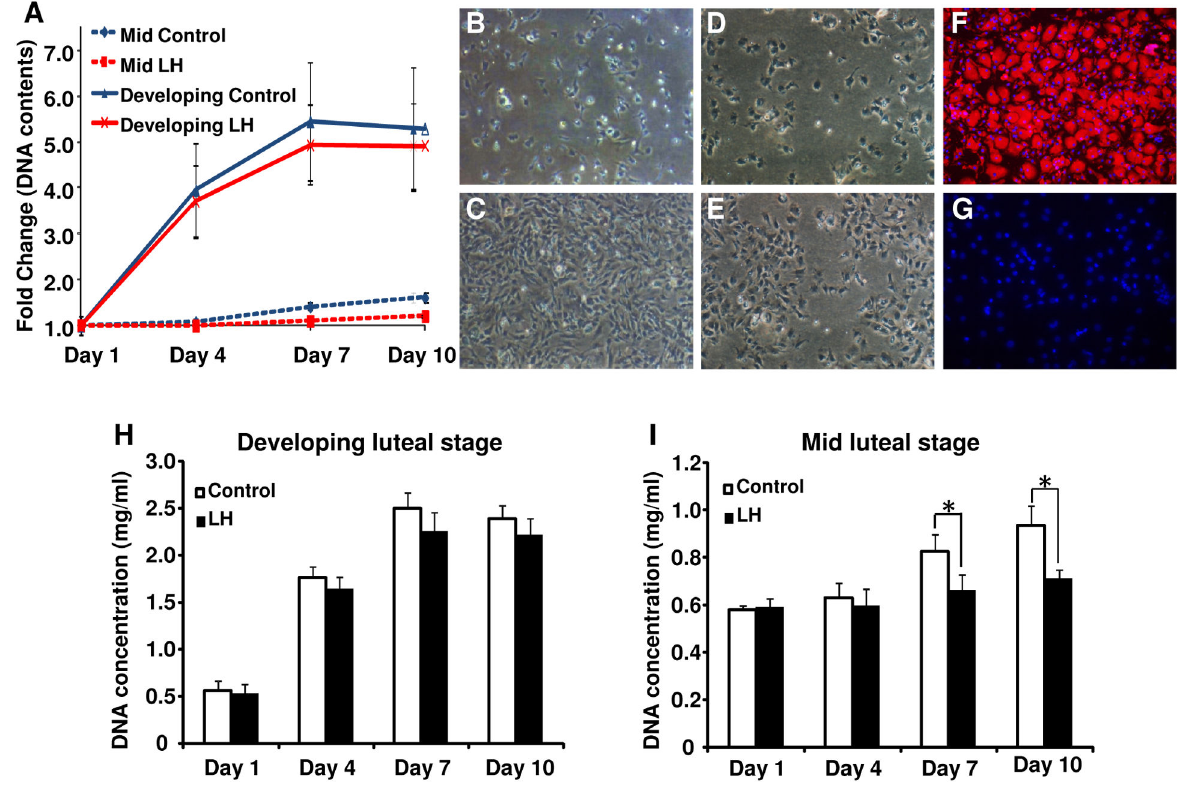
Figure 5. Proliferation of cultured LSCs. (A) Cellular proliferation was determined by DNA assay at the indicated times with or without LH (10 ng/ml) after the LSCs were seeded (n=5). Daily observation of luteal steroidogenic cells at (B) 1, (C) 4 days from developing CL and (D) 1, (E) 4 days from mid CL were shown. To confirm that cultured cells were steroidogenic cells, the LSCs isolated from mid luteal stage were cultured for 24 h, then immunohistochemical staining with HSD3B was performed (F). PBS was used as a negative control (G). (H) and (I) show the effect of LH (10 ng/ml) on cellular proliferation of bovine luteal cells isolated from the developing and mid CL, respectively (mean±SEM, n-5 experiments). Asterisks indicate that LH had a significant effect on DNA concentration (P<0.05), as determined by ANOVA followed by Fisher’s PLSD as a multiple comparison test. doi: